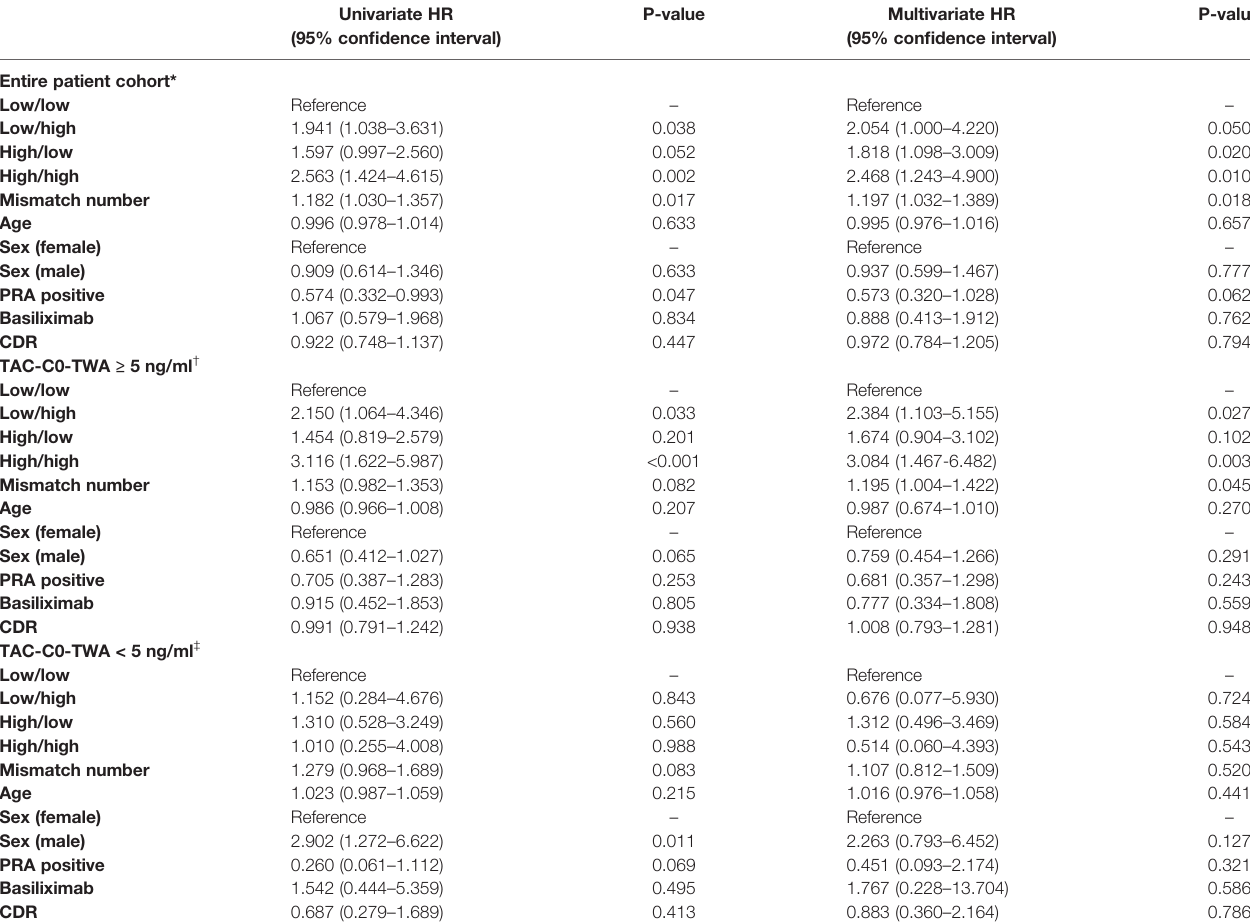
TABLE 5 | Multivariate Cox proportional hazard ratio model analysis for DCGL including TAC-C0-TWCV during post-transplant 0 – 1 st and 1 st – 2 nd